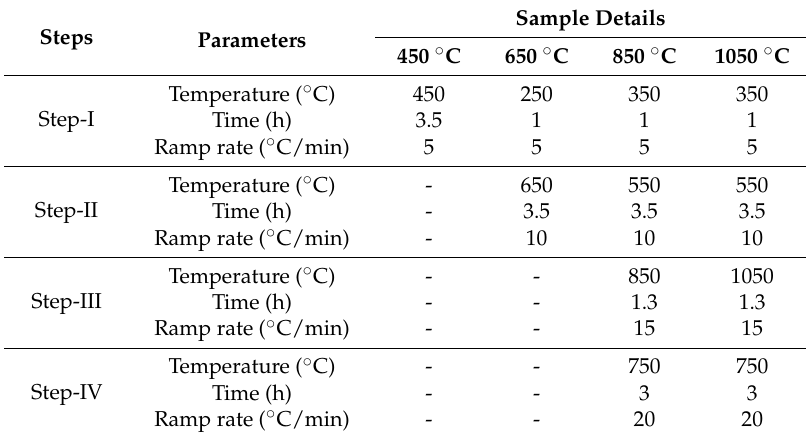
Table 1. Schematic sintering steps of the samples 450, 650, 850, and 1050 ˝